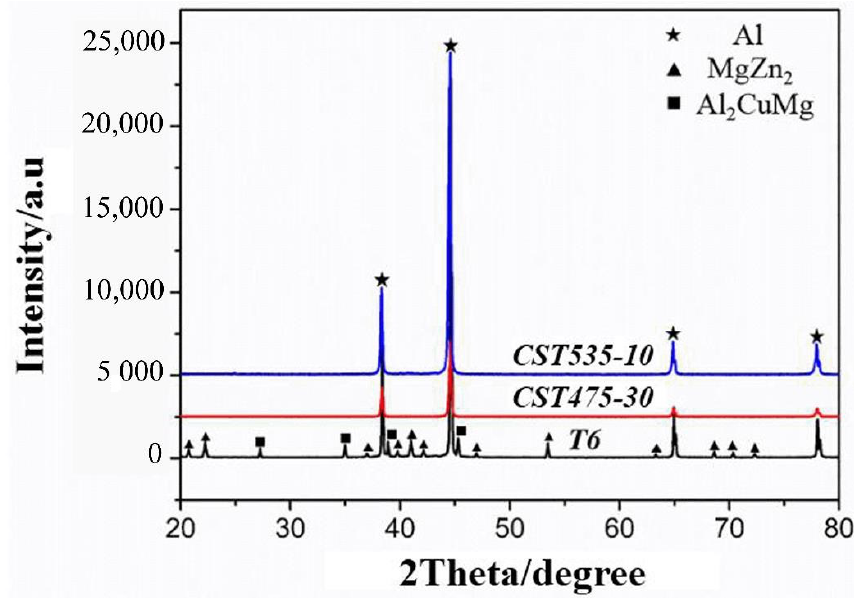
Figure 5. X-ray diffraction (XRD) with different solution temperatures.